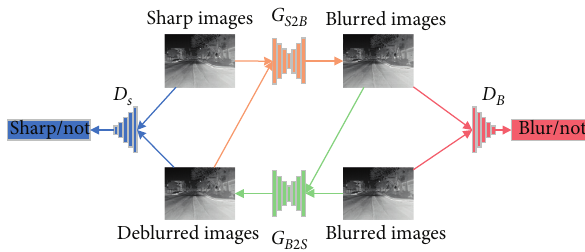
Figure 1: The overall structure of the proposed